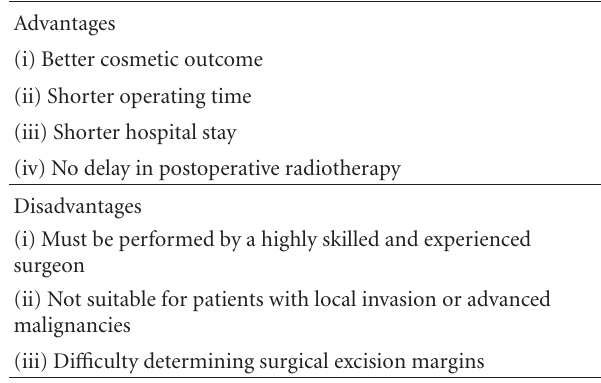
Table 1: Key advantages and disadvantages of transnasal endo- scopic